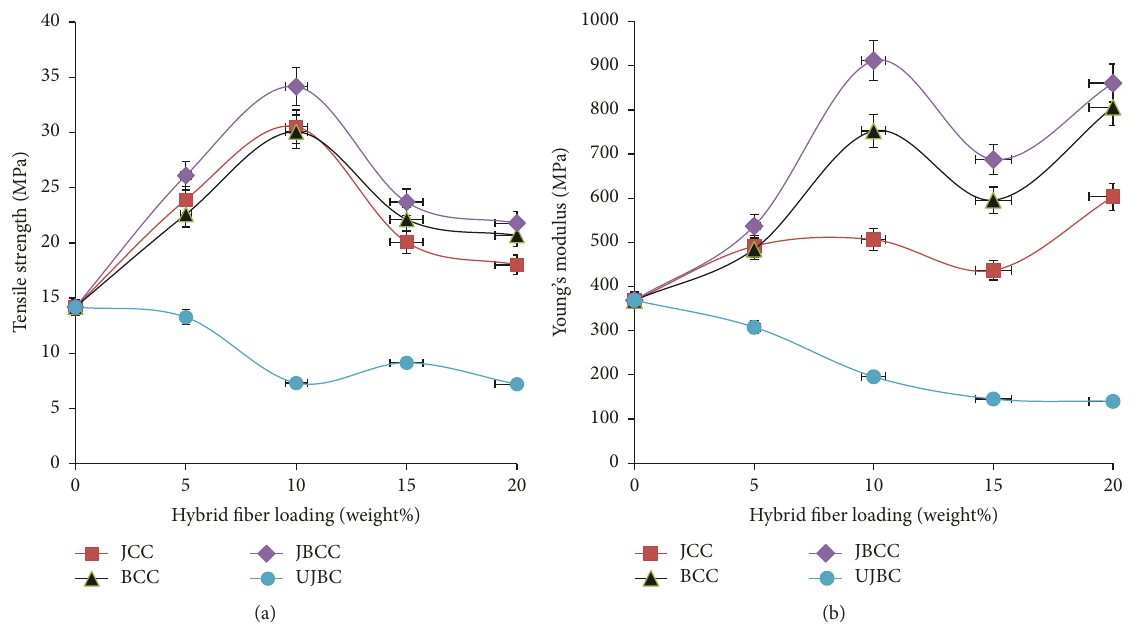
Figure 6: (a) Tensile strength of composite at different fiber loading. (b) Young’s modulus of composite at different fiber loading.